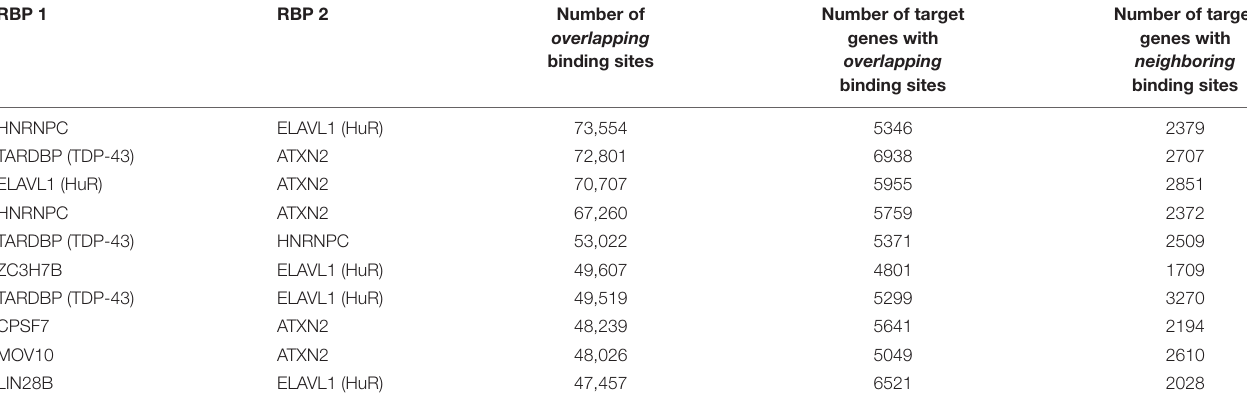
TABLE 3 | List of RBP-RBP pairs that have the highest number of overlapping and neighboring binding sites. RBP 1 RBP 2 Number of